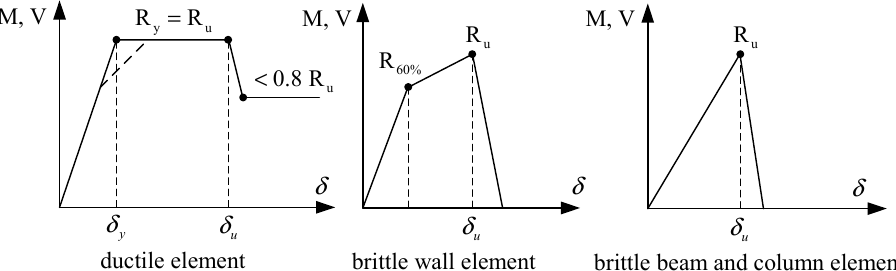
Figure 9. Typical force–deformation relation for RC elements.